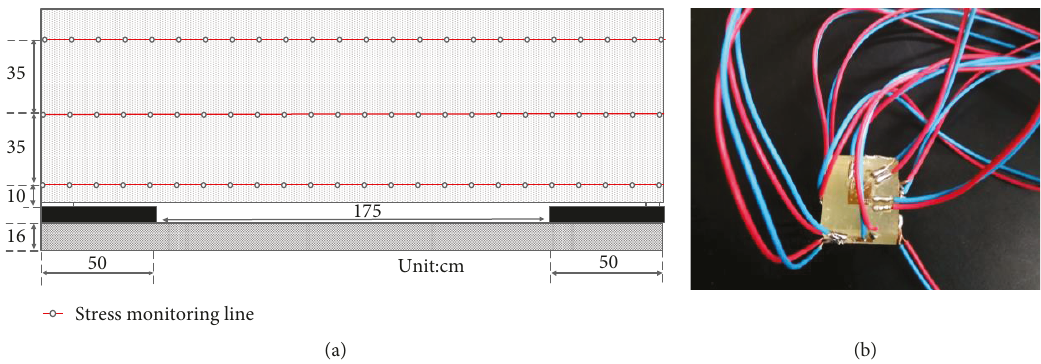
Figure 7: Schematic diagram of monitoring lines and strain sensor. (a) Stress monitoring lines. (b) Strain sensor.